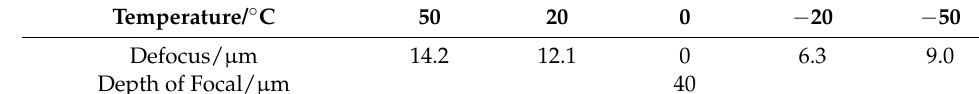
Table 5. Defocus values of the optical system.